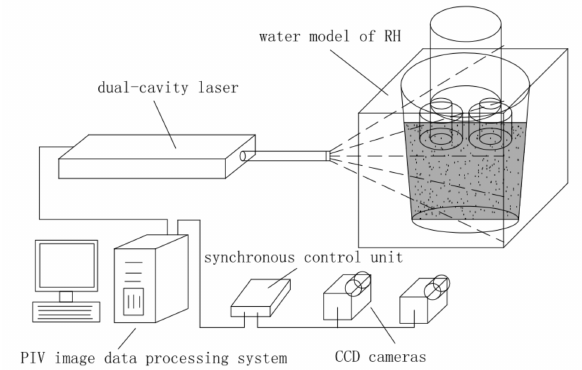
Figure 2. Particle image velocimetry (PIV) velocity measurement system of RH.